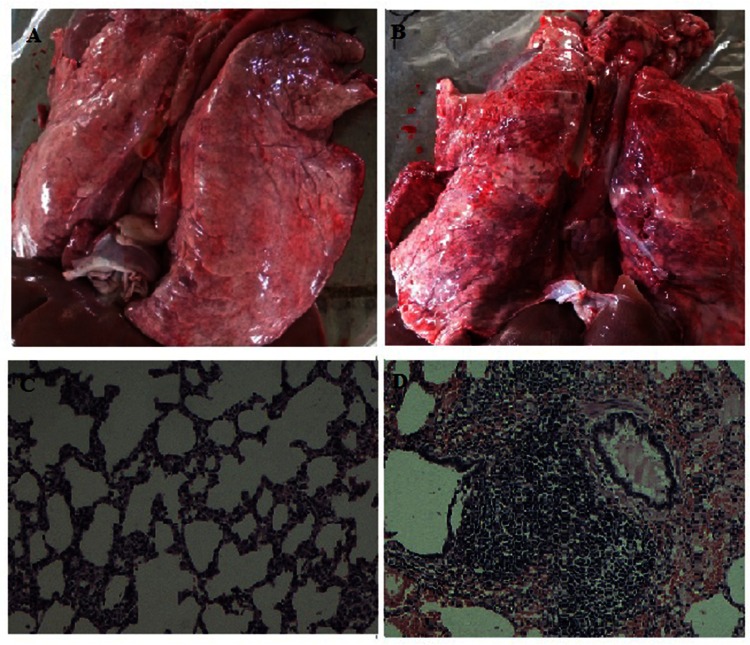
Pathological changes in lung tissue after PCV2 infection.The necropsy (A) and tissue slice (C) results of LW-i pigs showed normal signs. The necropsy (B) and tissue slice (D) results of YL-i pigs showed serious clinical signs: congestion, bleeding, interstitial pneumonia and lymphocyte infiltration in the bronchus determined by hematoxylin and eosin staining (× 200).